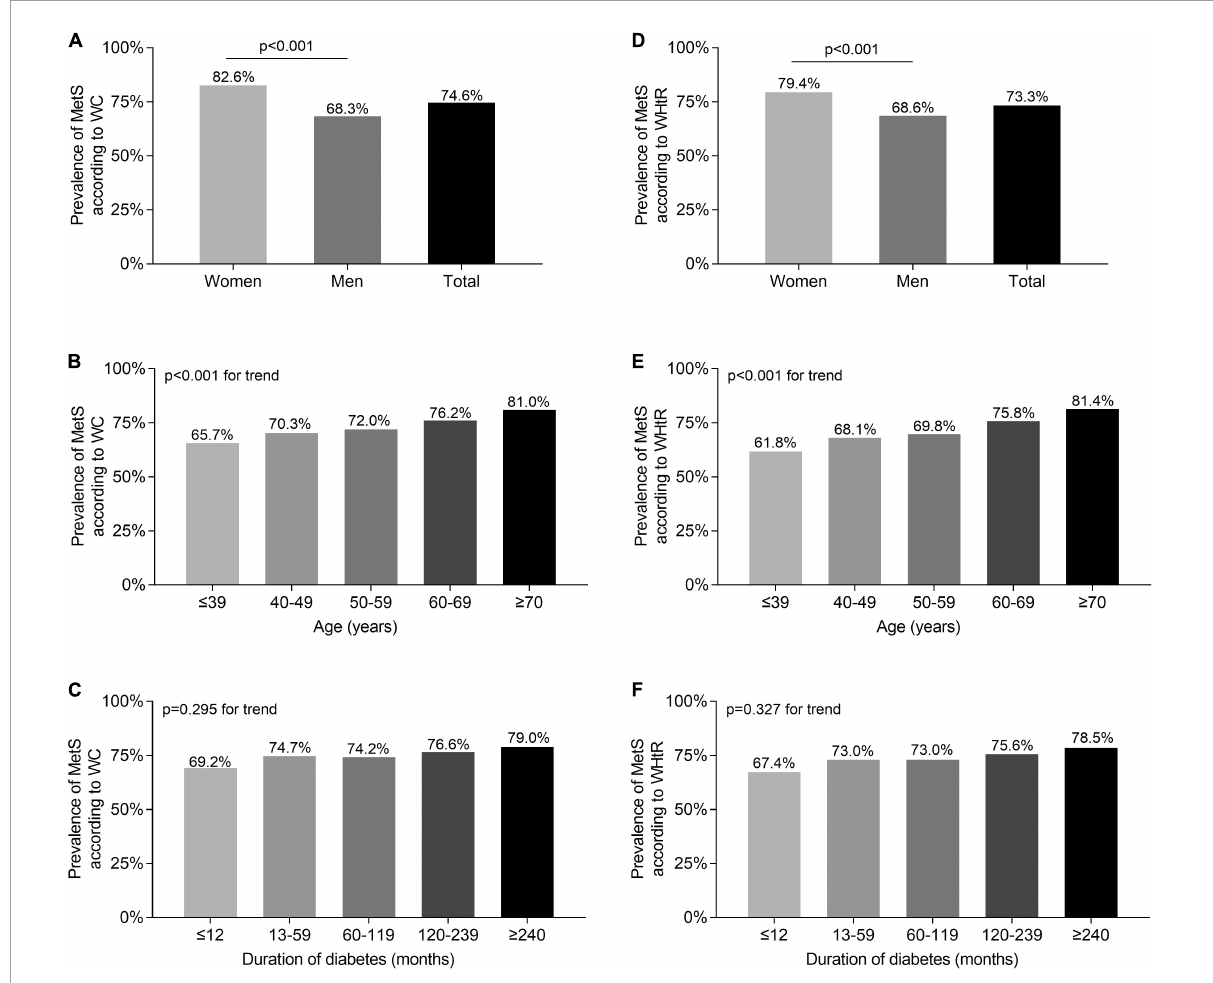
FIGURE1 Comparisons of MetS prevalence diagnosed according to WC and WHtR in T2DM patients. (A) Comparison of the prevalence of MetS diagnosed by WC stratified by sex after adjusting for age and DD. (B) Comparison of the prevalence of MetS diagnosed by WC stratified by age after adjusting for sex and DD. (C) Comparison of the prevalence of MetS diagnosed by WC stratified by DD after adjusting for sex and age. (D) Comparison of the prevalence of MetS diagnosed by WHtR stratified by sex after adjusting for age and DD. (E) Comparison of the prevalence of MetS diagnosed by WHtR stratified by age after adjusting for sex and DD. (F) Comparison of the prevalence of MetS diagnosed by WHtR stratified by DD after adjusting for sex and